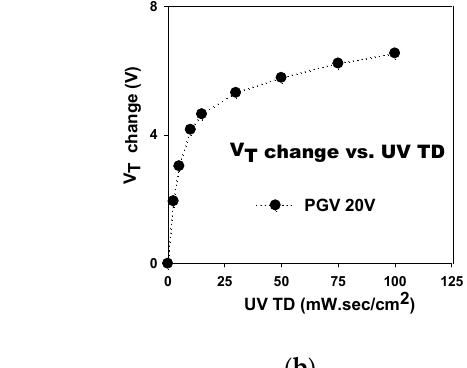
UV TD irradiation at PGV 30V.